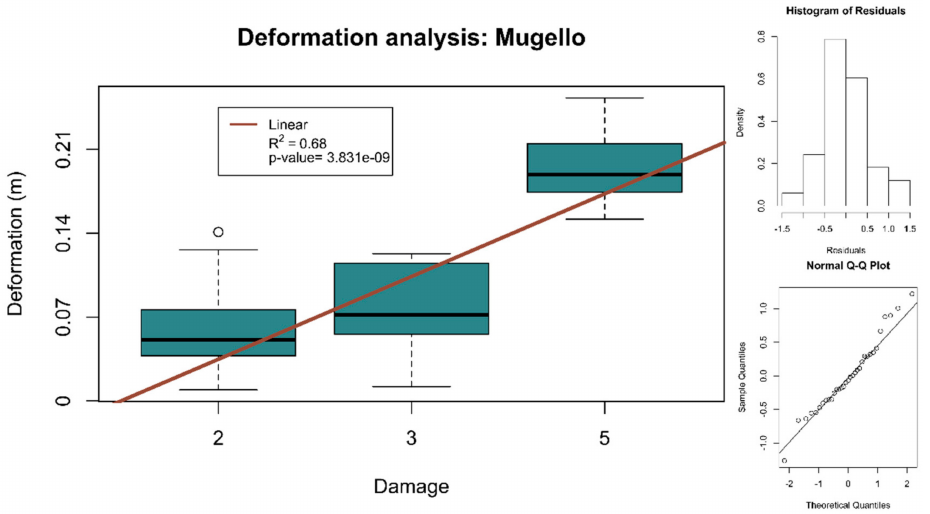
Figure 6. Relationship between the subjective damage scale (Table 1) and the in situ deformation measurements (D f or D b ) of the dry-stone walls in the Mugello region. The graphs on the right show the histogram and Q-Q plot of the residuals of the regression model—Boxplot: Box = 1.5 × IQR, Q1, Q2, Q3; Whiskers = Min and Max.